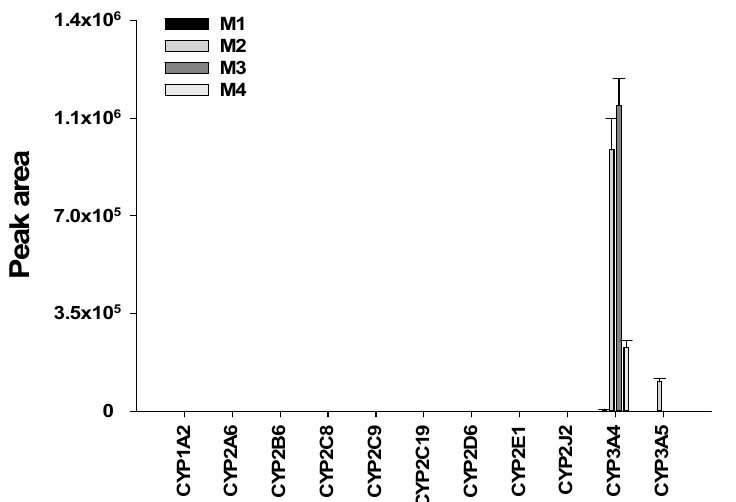
Figure 6. Representative plots of the formation of hydrolyzed seongsanamide A (M1), mono- (M2), di- (M3), and tri-hyroxyseongsanamide A (M4) from seongsanamide A by recombinant human cytochrome P450 isoforms. Human recombinant cytochrome P450s 1A2, 2A6, 2B6, 2C8, 2C9, 2C19, 2D6, 2E1, 2J2, 3A4, and 3A5 were incubated with seongsanamide A (1 µM) at 37 °C for 15 min in the presence of an NADPH generating system. Error bars represent standard deviations ( n = 3).